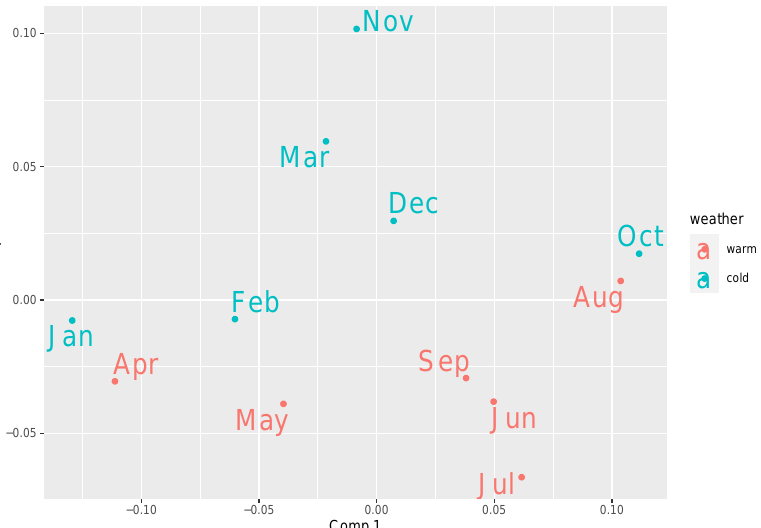
Figure 9. Graphical representation of the months embedding z s ( s ) ∈ R 5 after the dimensionality reduction (from 5 to 2) via principal component